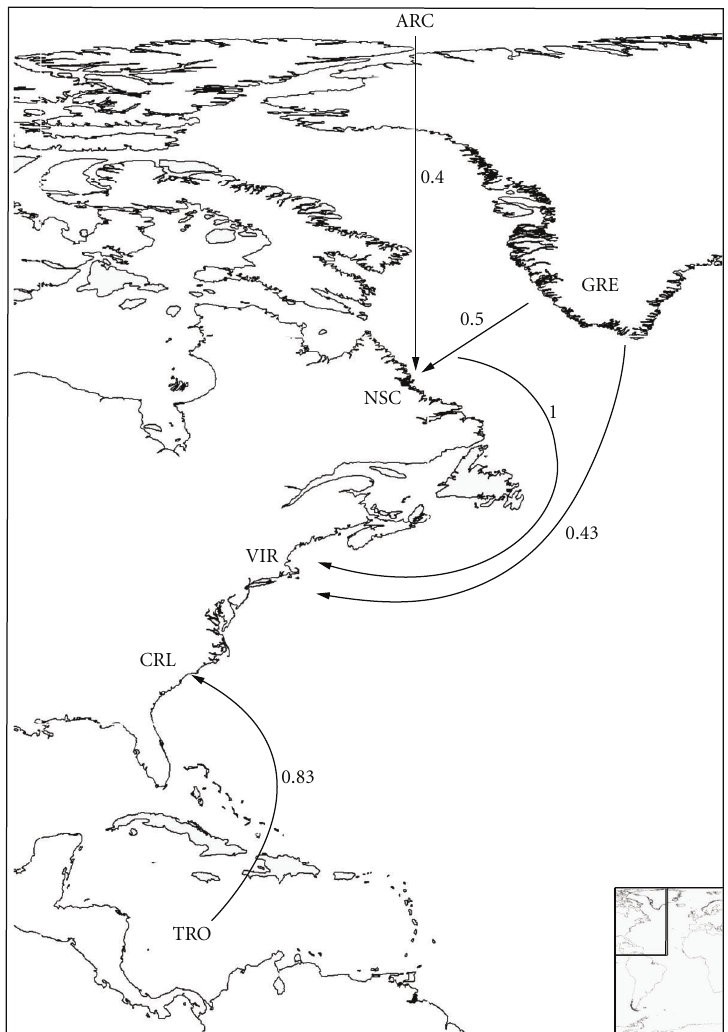
Figure 4: Probable colonization patterns of rissoid fauna in the Northwest Atlantic. The arrows represent the probable main flux direction of faunas, and the associated numbers represent, for each pair of areas, the higher of the two similarity index values computed as described in the methods, abbreviations as in Table